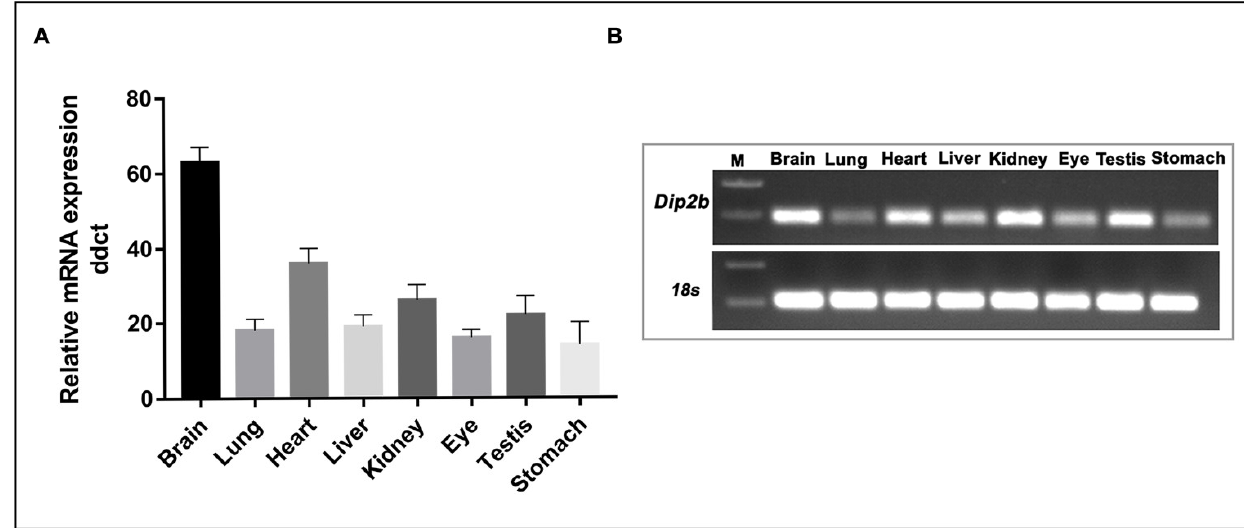
Figure 9. qPCR results for total RNA of 8-week-old tissues. ( A ) Relative mRNA levels were calculated using the ddCt method. Data shown are representative of at least three independent experiments and expressed as the mean ± SD. ( B ) Confirmation of the specificity of product produced by qPCR using gel electrophoresis. Table 1. Summary of expression pattern revealed by X-gal staining of Dip2b tm1a/+ mice.